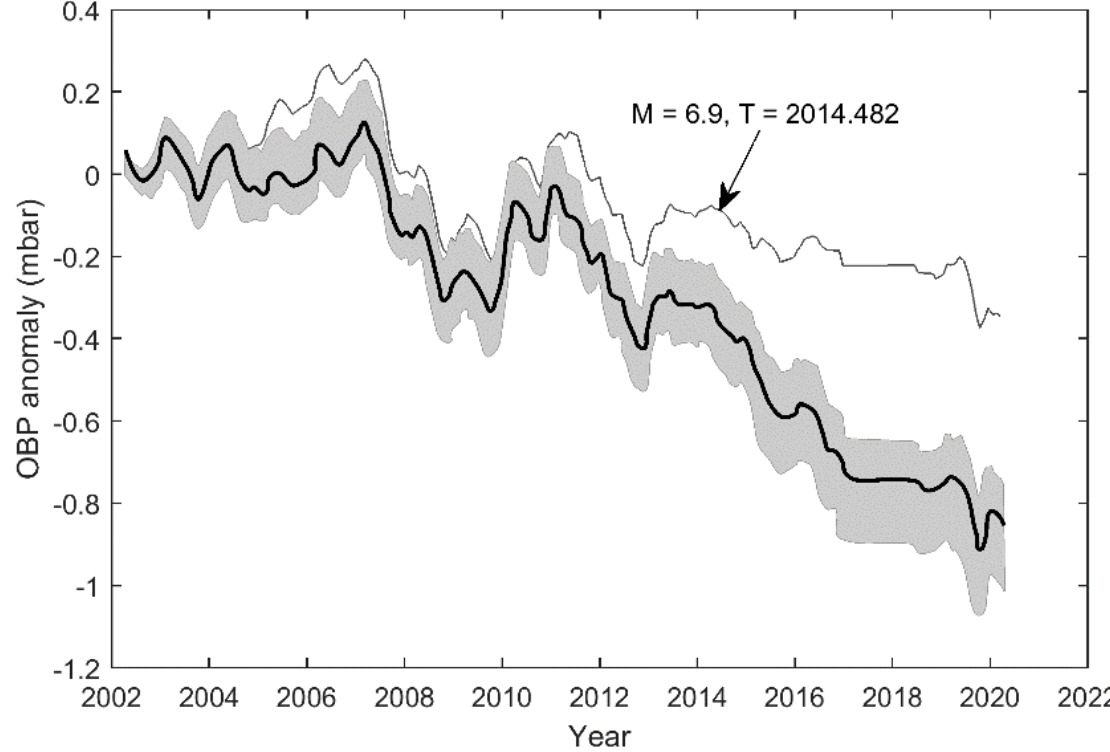
Figure 4. OBP anomaly range for 14 selected earthquake locations (grey area). A solid black line indicates the time- averaged OBP anomaly time series for the selected locations. The outstanding plot represents the OBP anomaly data for the M = 6.9 earthquake location (40.29N, 25.39E) at the 2014.482 epoch. This location belongs to the North Anatolian fault zone (NAFZ).